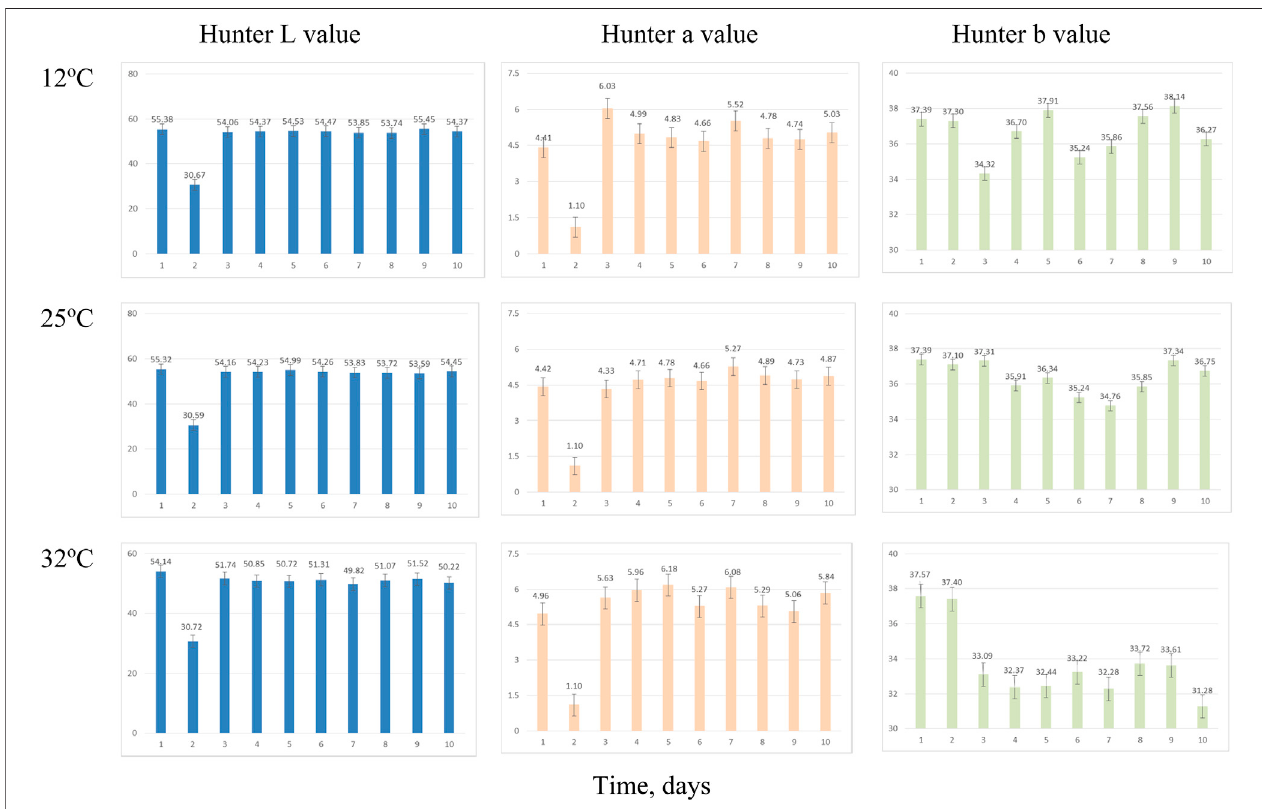
FIGURE 9 | Average Hunter color values over time for syrup sampling due to incubation temperatures. Error bars denote 1 standard deviation.